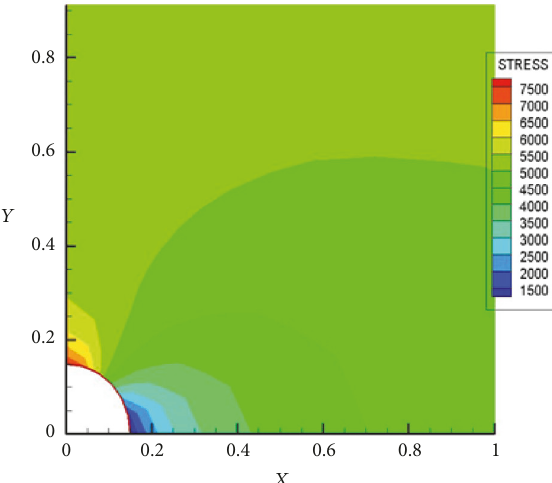
Figure 8: 𝑋 -component of radial stresses contour map after 1hr of fluid production (for near-wellbore region) with 𝜎 𝐻 = 5800 psi and 𝜎 𝑃 𝑃 𝑘 𝑘 ℎ = 5500 psi, 𝑟 = 5500 psi, 𝑤 = 1000psi, 𝑥 = 0.01md, and 𝑦 = 0.01 md.